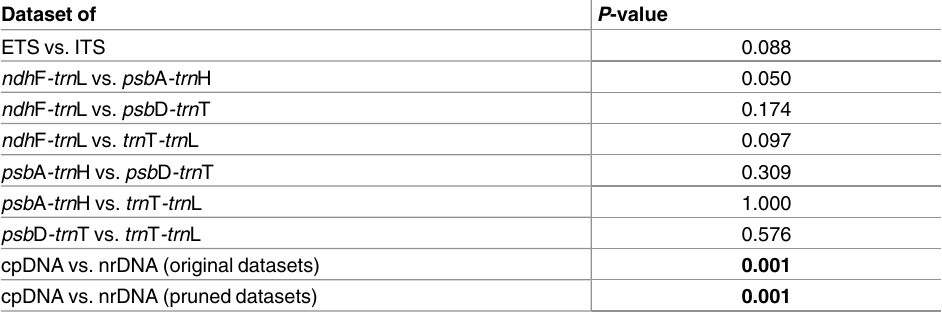
Table 3. P -values of the partition-homogeneity tests. The pruneddatasets are reconstructed from the originaldatasets by excluding Acontium apetalum , two accessions of A . barbatum var. barbatum (ZY69 and GQ150), A . fletcheranum , A . gigas var. hondoense , and A . moschatum . Bold-facedvalues indicaterejection of the null hypothesis with 95% confidence. Dataset of P -value